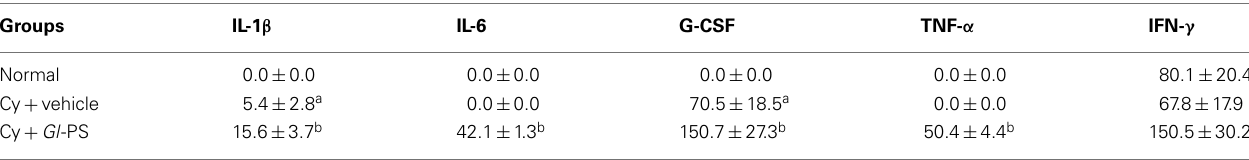
Table 2 | Comparison of serum cytokine concentrations (pg/ml) in naive and myelosuppressed mice treated with Gl -PS (i.p., 2.5mg/kg) on day 11.